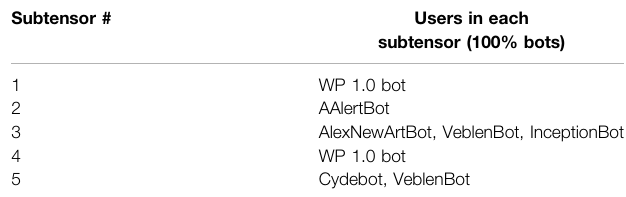
TABLE 7 | D-Cube successfully spots bot activities in the EnWiki dataset. Subtensor